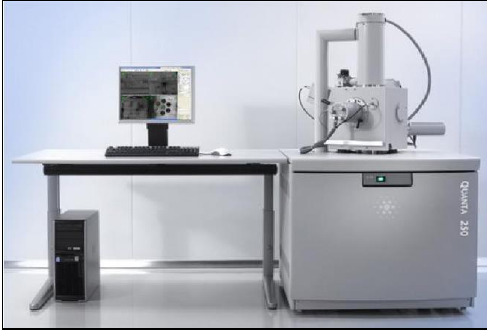
Figure 3. FEI Quanta TM 250 SEM.